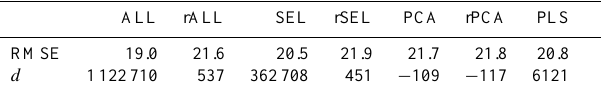
Table 3. 10-fold cross validation errors ( RMSE ) measured on the Table 3. Tenfold cross-validation errors (RMSE) measured based training dataset and deterioration index ( d ). on the training data set and deterioration index ( d